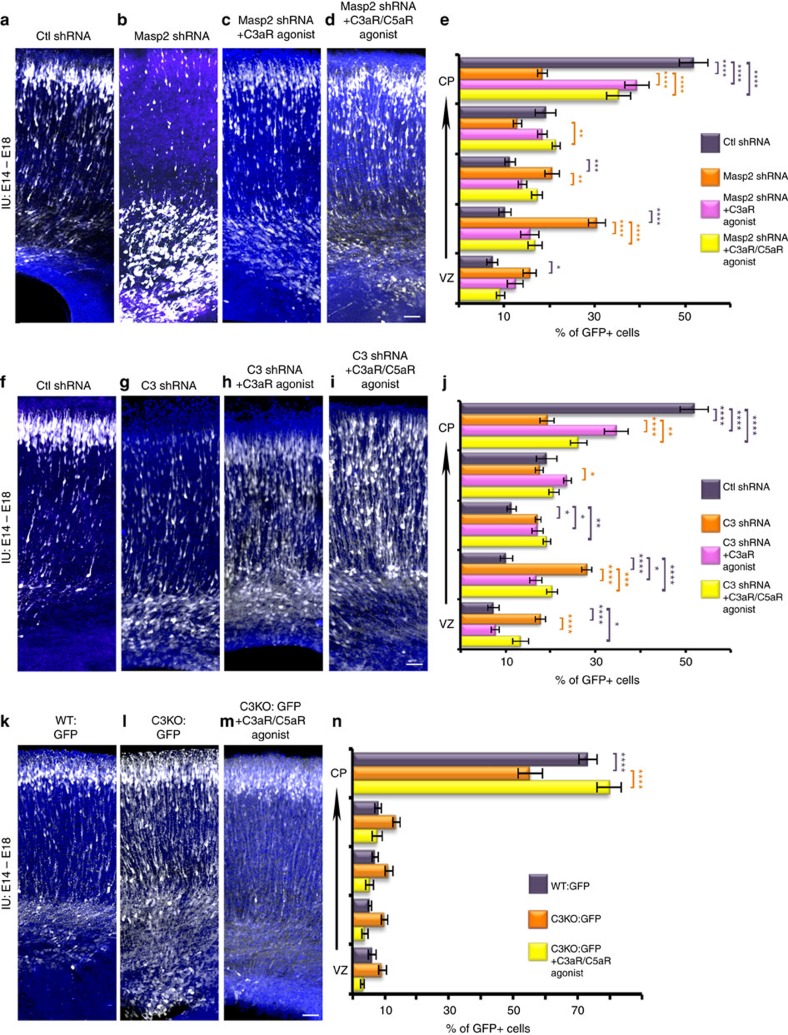
Neuronal migration impairment by either knockdown of Masp2 or C3, or knockout of C3 is ameliorated by activation of the C5a and/or the C3a receptors.(a–e) Treatment by Masp2 shRNA (b, n=4) electroporated in utero (E14–E18) is partially rescued by addition of C3aR agonist (c, n=5) or the dual receptor agonist (d, n=3). Quantification of the distribution of neurons across the cortex is shown for all the treatments (e). All the treatments were compared to control shRNA (a, n=4, the statistical significance is shown in violet) or Masp2 shRNA (the statistical significance is shown in orange). (f–j) Knockdown of C3 (g, n=4) electroporated in utero (E14–E18) is partially rescued by either addition of C3aR agonist (h, n=4) or the dual receptor agonist (i, n=4). Quantification of the distribution of neurons across the cortex is shown for all the treatments (j). All the treatments were compared to control shRNA (f, n=4, the statistical significance is shown in violet) or C3 shRNA (the statistical significance is shown in orange). (k–n) Knockout of C3 is rescued by addition of the dual agonist. C3 KO embryos were electroporated in utero (E14–E18) with a GFP expression construct (l, n=6), or with a GFP expression construct together with the C3a/C5a receptors agonist (m, n=4). None of the agonist treated brains showed any neuronal migration impairment. Comparison to the WT (k, n=3) is shown in violet. Comparison to C3 KO is shown in orange, histograms present means±s.e.m.